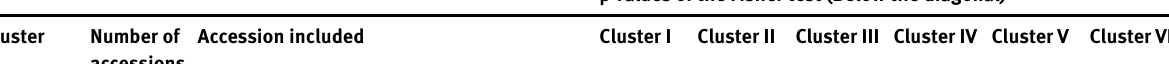
Mahalanobis inter-cluster distance values (Above the diagonal) and p values of the Fisher test (Below the diagonal)